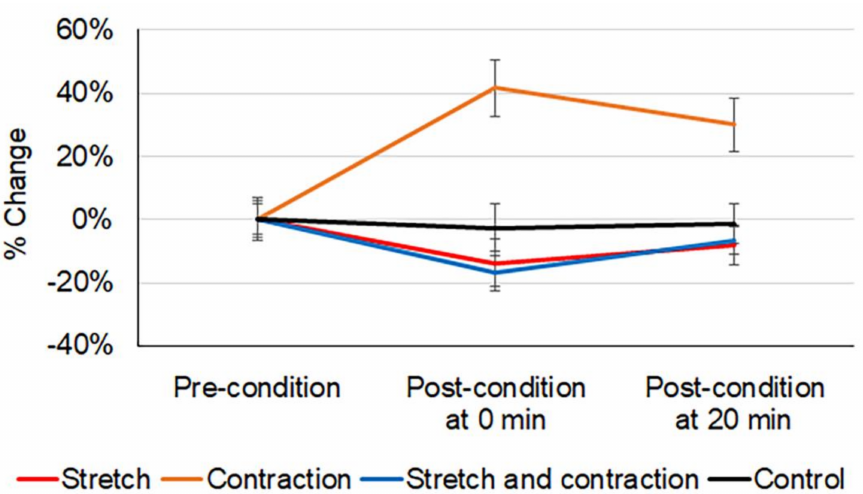
Figure 4. Quadriceps spinal-reflex excitability expressed as percentage change from the pre-condition measurement. Error bars are upper and lower values of 95% confidence intervals. After the contrac- tion condition, quadriceps spinal-reflex excitability was increased at post-condition at 0 min (42%, ES = 0.63), and the increased value was maintained for 20 min (30%, ES =